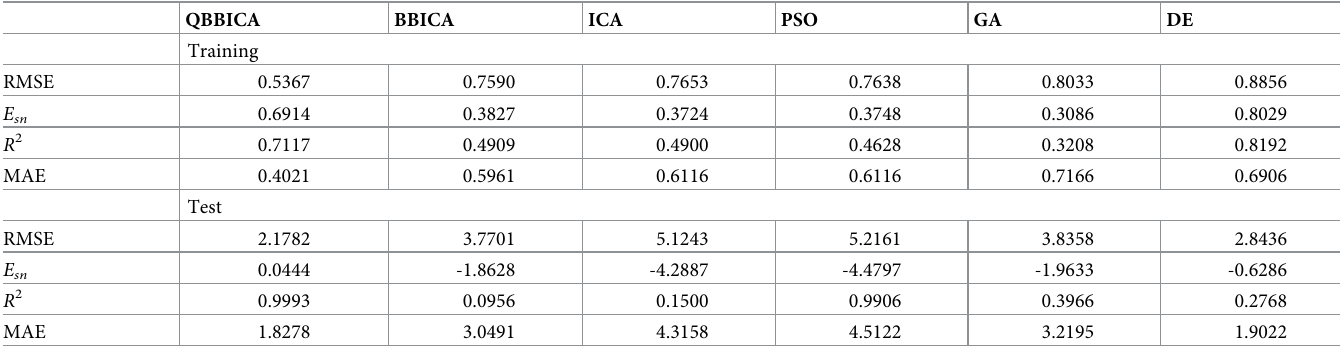
Table 9. Performance indices of Sig-FCM.